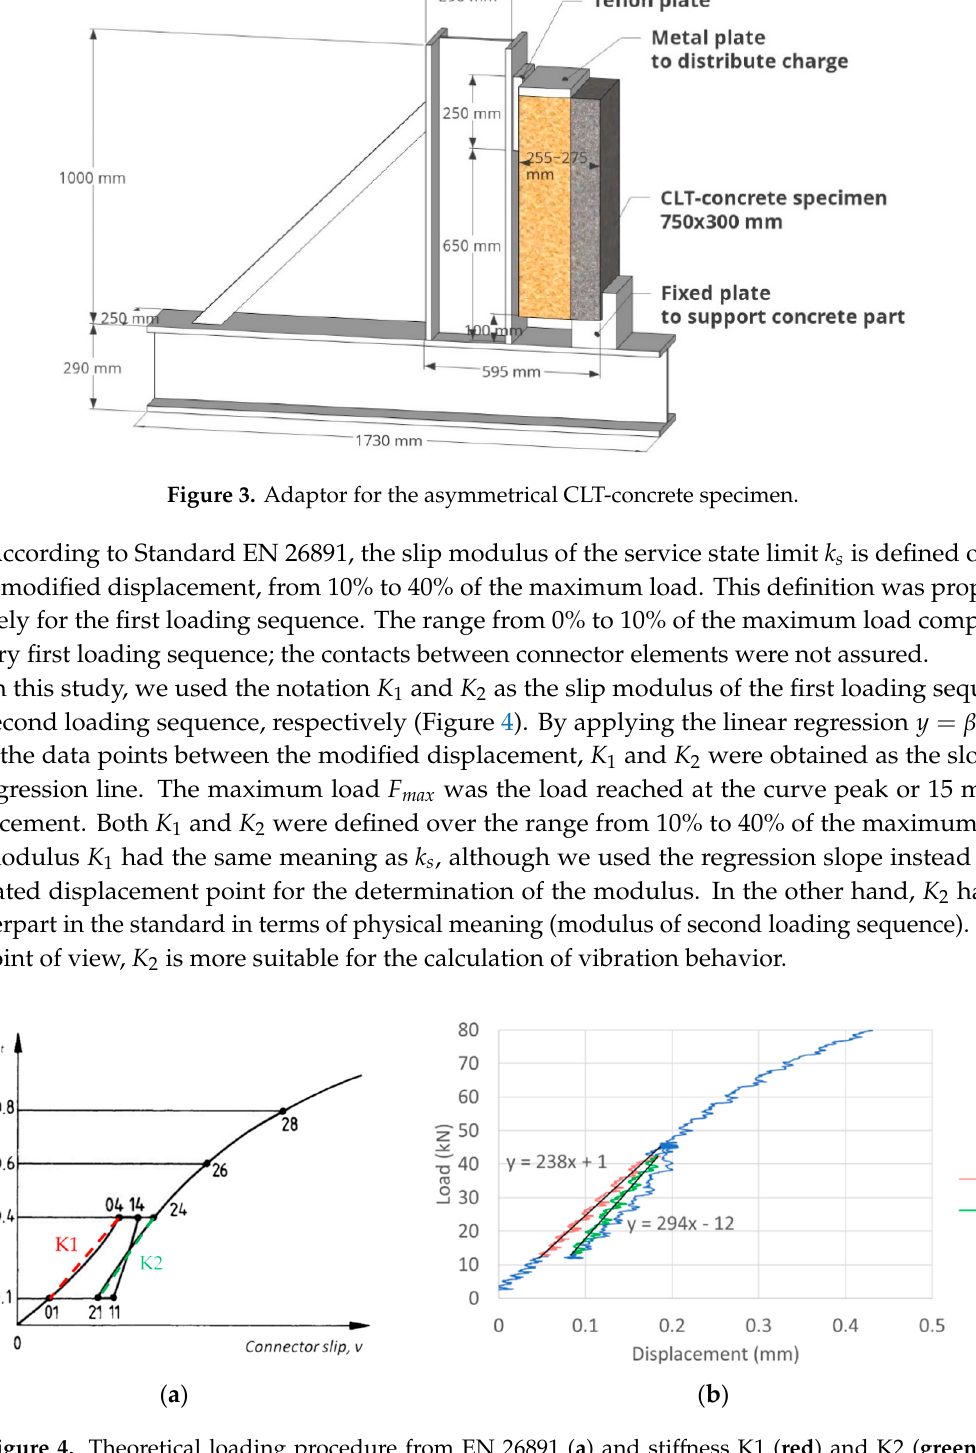
Figure 4. Theoretical loading procedure from EN 26891 ( a ) and stiffness K1 ( red ) and K2 ( green ) determination of specimen A2 ( blue ) on raw data representation ( b ).